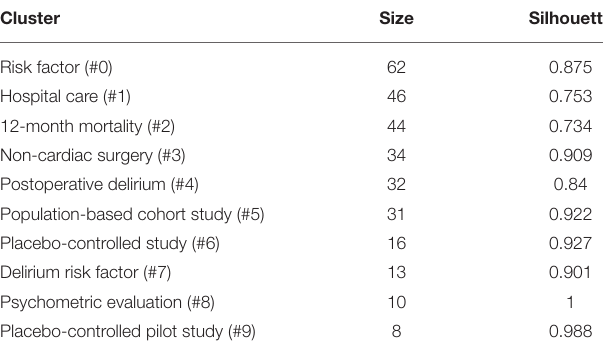
TABLE 5 | The 10 clusters in the map of keyword